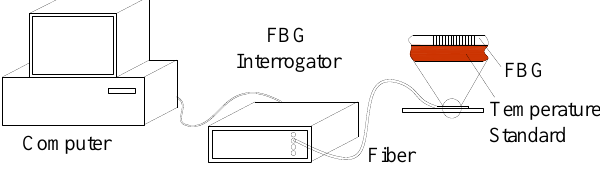
Figure 5. Surface error measurement principle schematic.